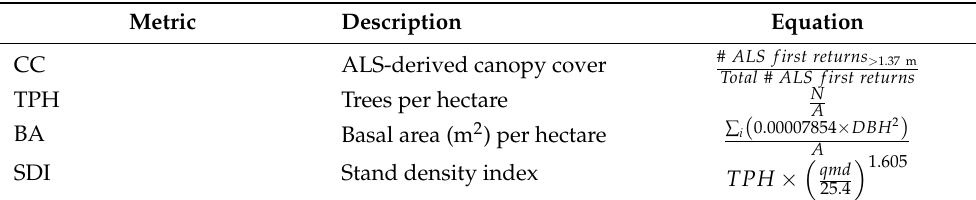
Table 3. Canopy cover and stand density metric descriptions and